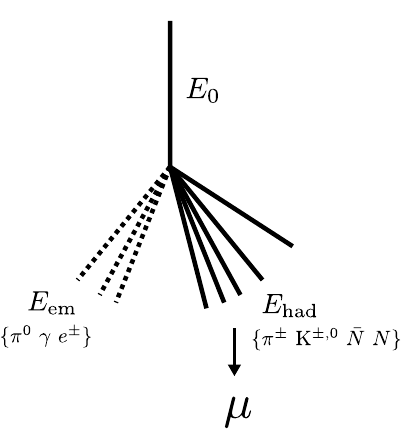
Figure 2. Energy flow in the first interaction into the em. and hadronic component of the shower.